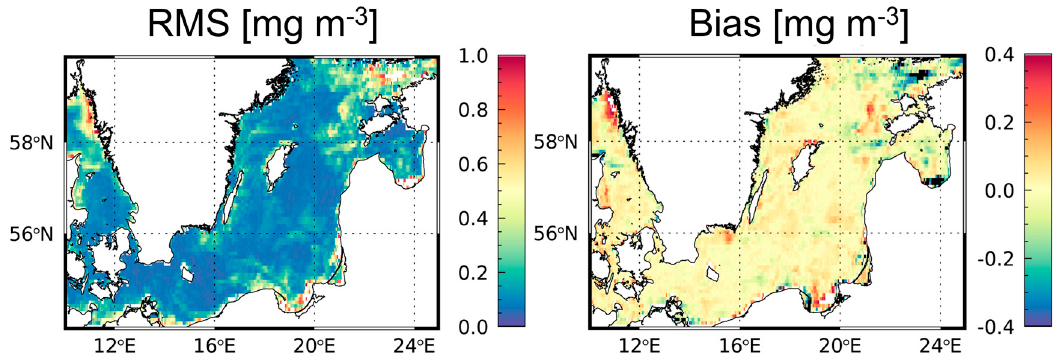
Figure 7. RMS and bias reconstruction errors using the entire time-series of daylight hourly observations with respect to the original hourly fields, in a GEO context.